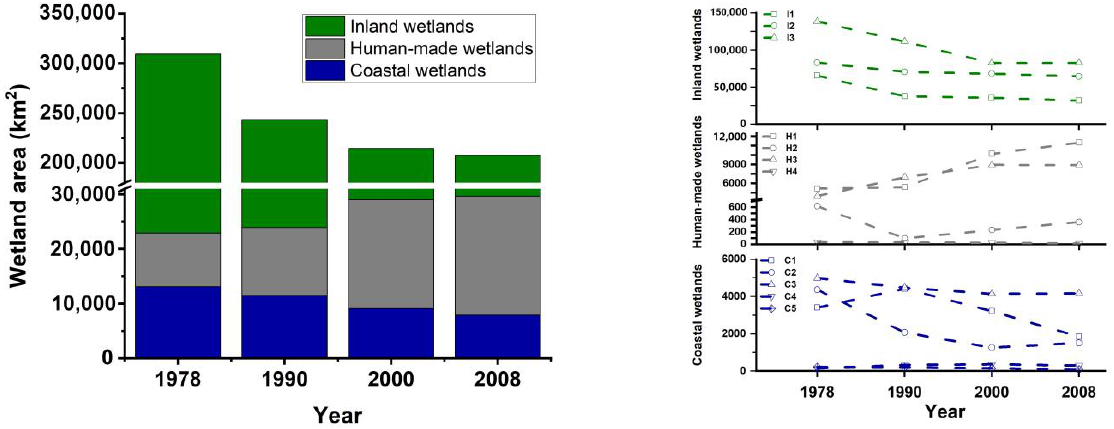
Figure 3. Area of three main wetland types ( left ) and subtypes ( right ) in China in 1978, 1990, 2000,